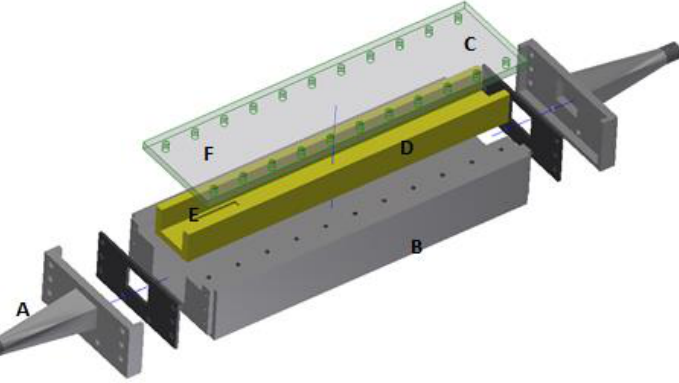
Figure 1. New design for a PPFC.